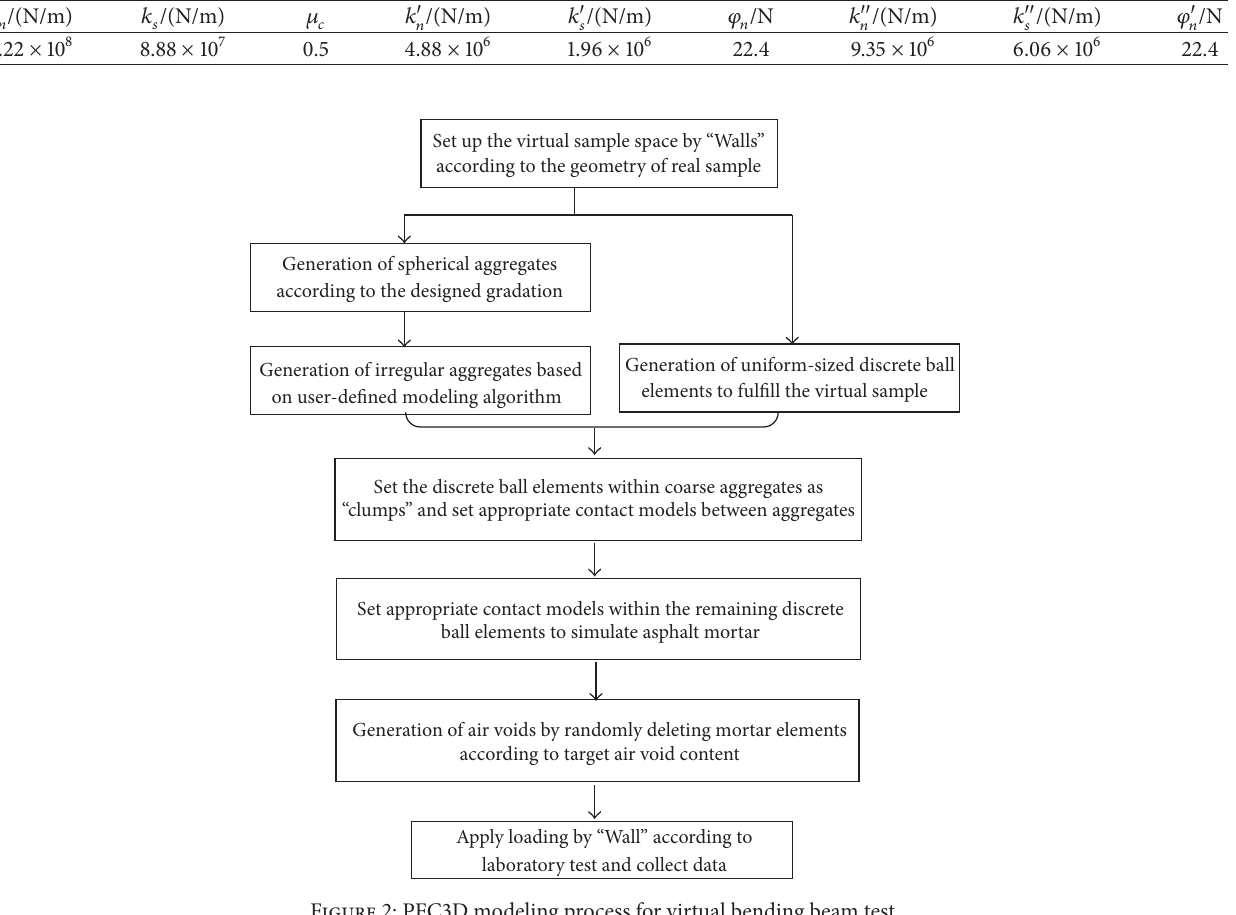
Figure 2: PFC3D modeling process for virtual bending beam test.